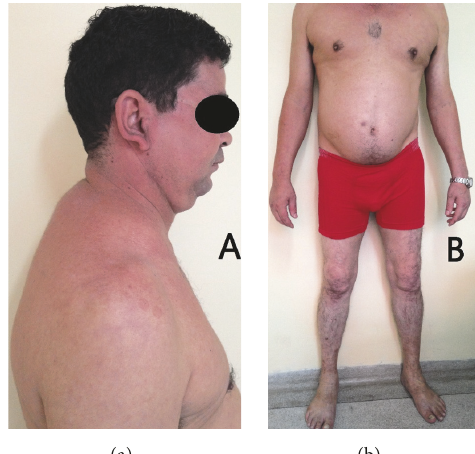
Figure 1: (a) Case 1: patient with Cushing’s syndrome secondary to systemic corticosteroid; (b) Case 1: patient without edema after recovered DVT in right leg.